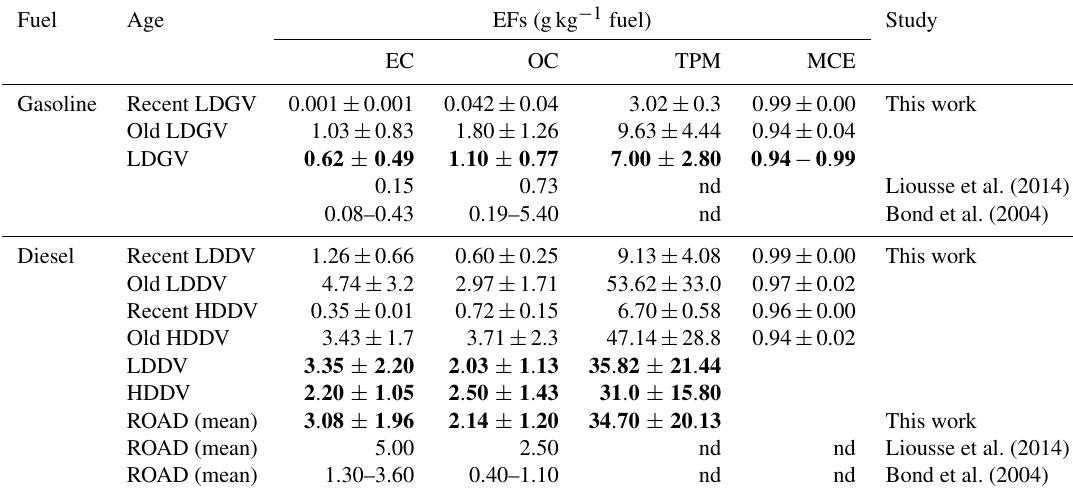
Table 2. Emission factors for gasoline and diesel vehicles by age group and those in the literature, from different measurement methods (mean values in